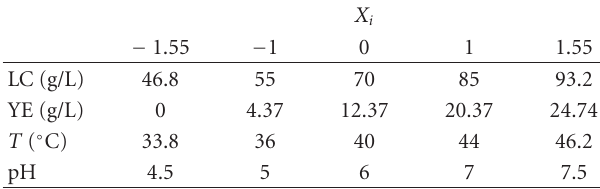
Table 1: Coded and actual values of the central composite